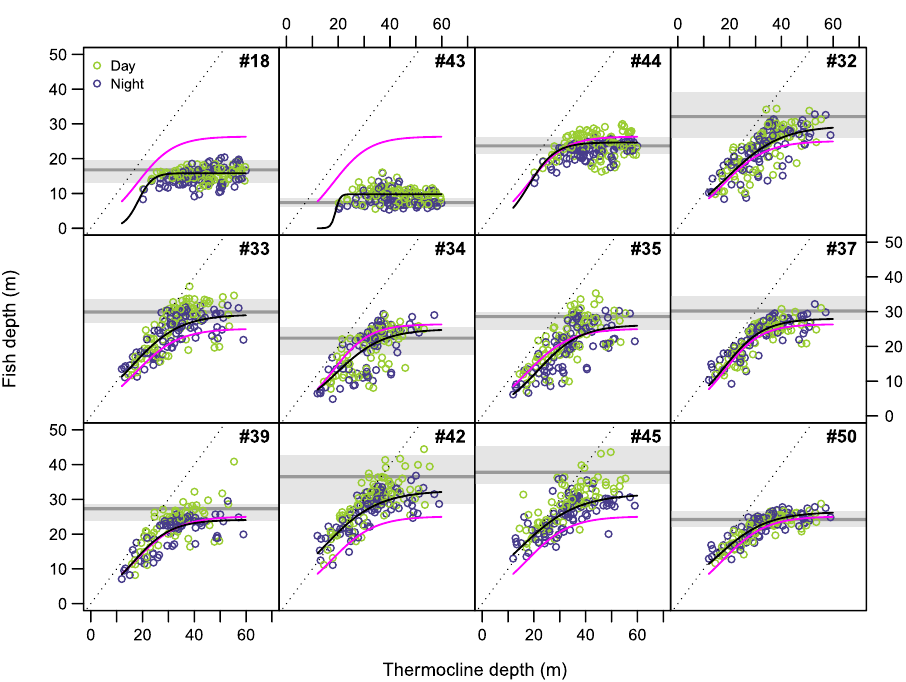
Figure 5. Relationship between mean fish depths and mean thermocline depths during the summer season, factorized by day/night periods, for each tagged fish (n = 12). Solid black lines represent the logistic models adjusted for each individual, and the magenta line is the mean prediction for the population. Black dotted lines highlight pure linear (1:1) relationships. Grey line and box in the bottom represent the median and the first and third quartiles, respectively, of the depths measured for each fish outside the summer